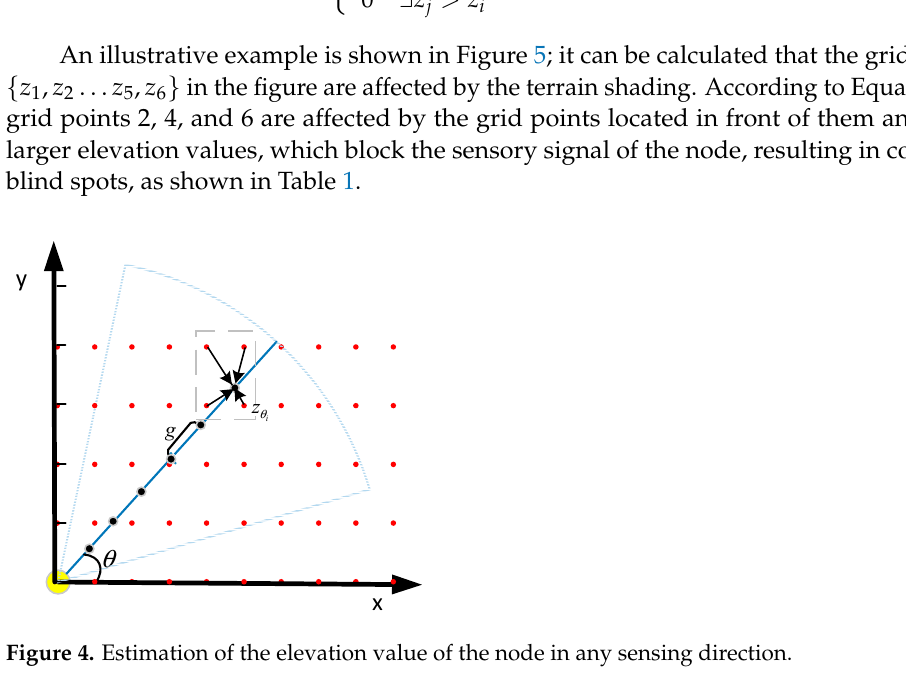
node with a sensing radius of r on a discrete grid point, taking the node coordinates as terrain occlusion. the origin, the sensing direction angle as the step direction, and / cos g θ